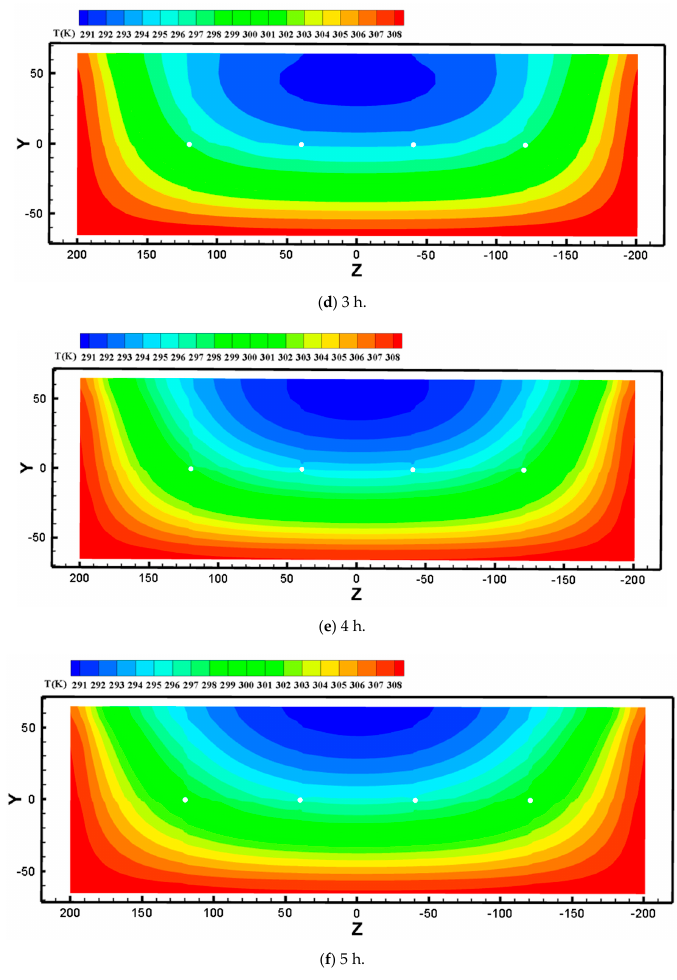
Figure 10. The temperature distribution of the backfill body during the heat storage process. Figure 11 shows the temperature distribution for section Y = 0 from the backfill body at different heat release times. The temperature of the backfill body in the heat transfer tube gradually decreased